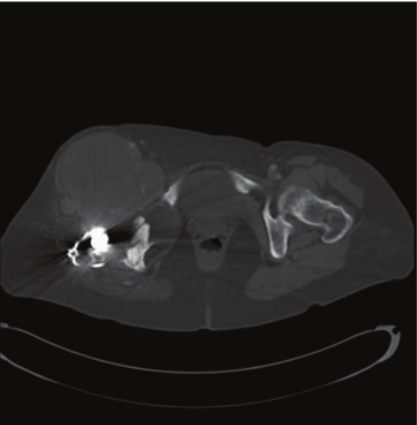
Figure 1: AP radiograph of pelvis revealing previous right total hip arthroplasty.